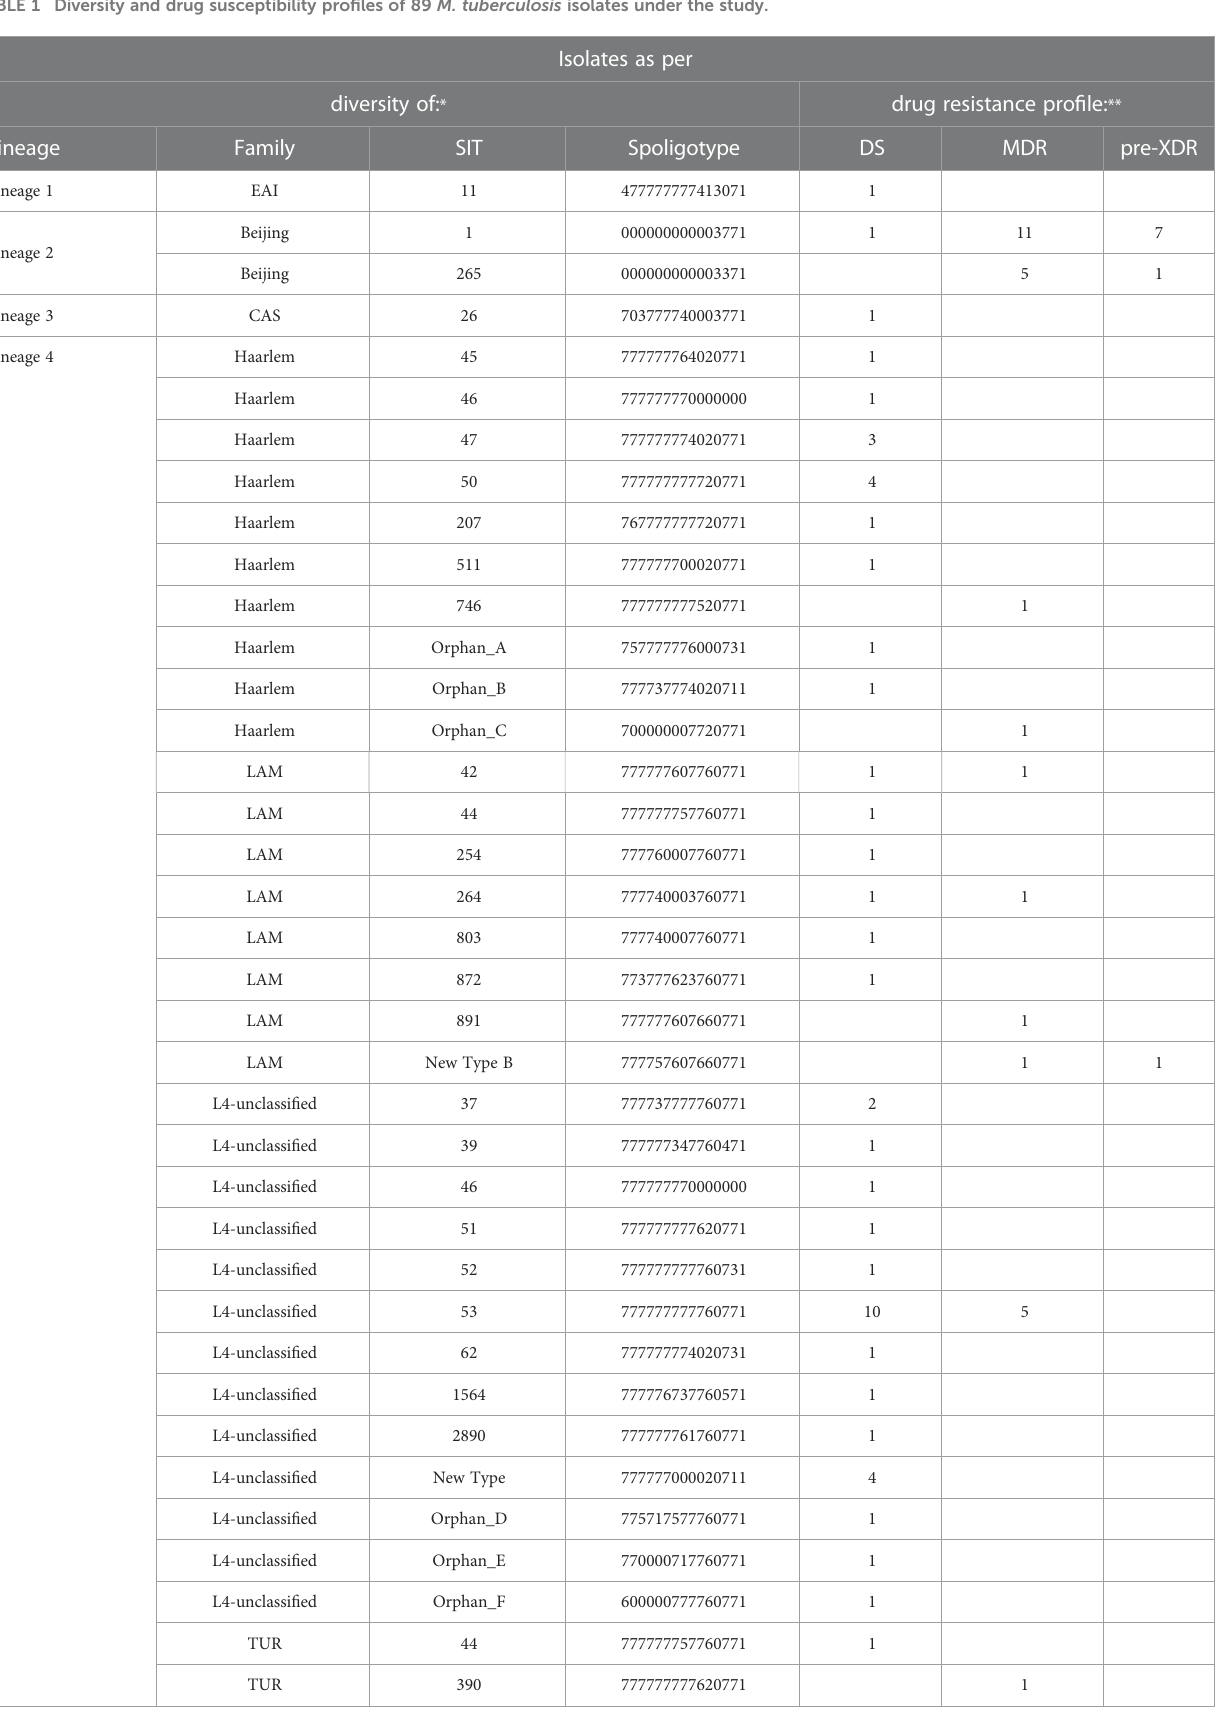
TABLE 1 Diversity and drug susceptibility pro fi les of 89 M. tuberculosis isolates under the